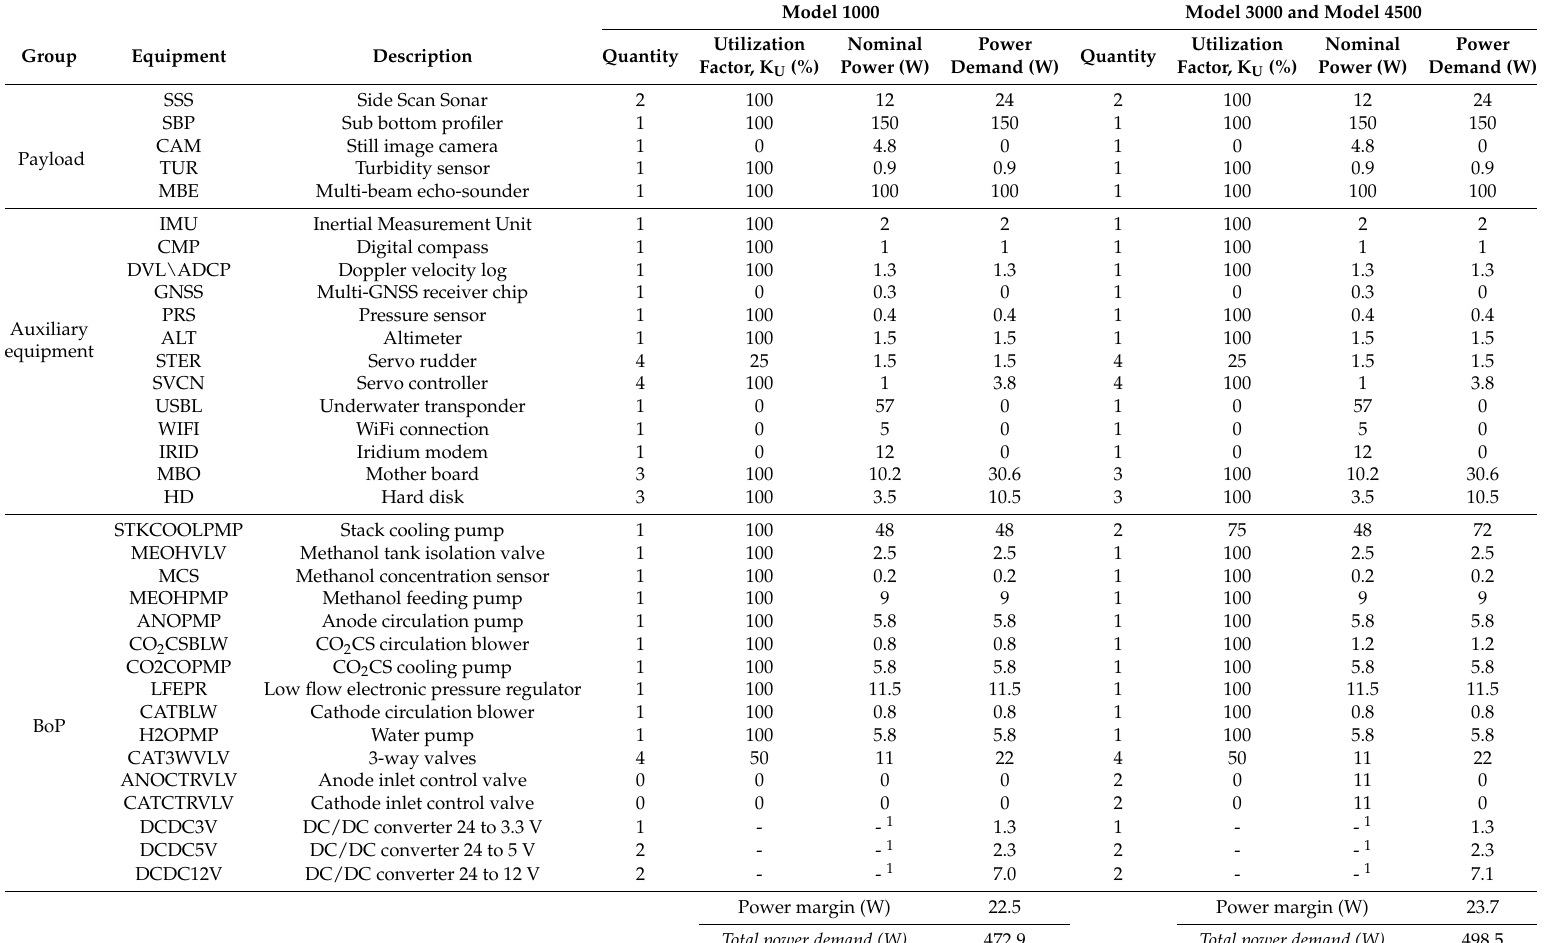
Table 3. Operational profile for a cruising speed of 2.058 m/s (4 knots). Power margin, 5%. Because both periods of the operational profile studied here are equal only the configuration of one of them is